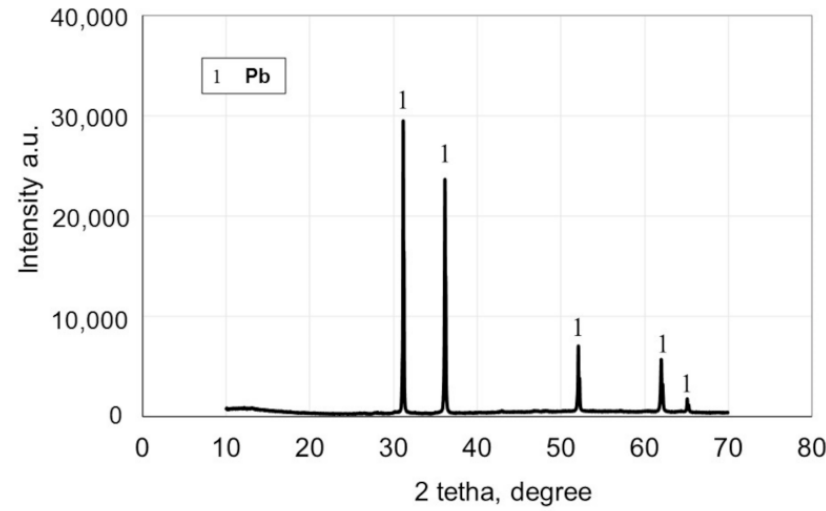
Figure 6. X-ray pattern for crude lead obtained for an initial charge of 40 wt.% of Na 2 CO 3 and 0.4 g of SiC to 1000 ◦ C.